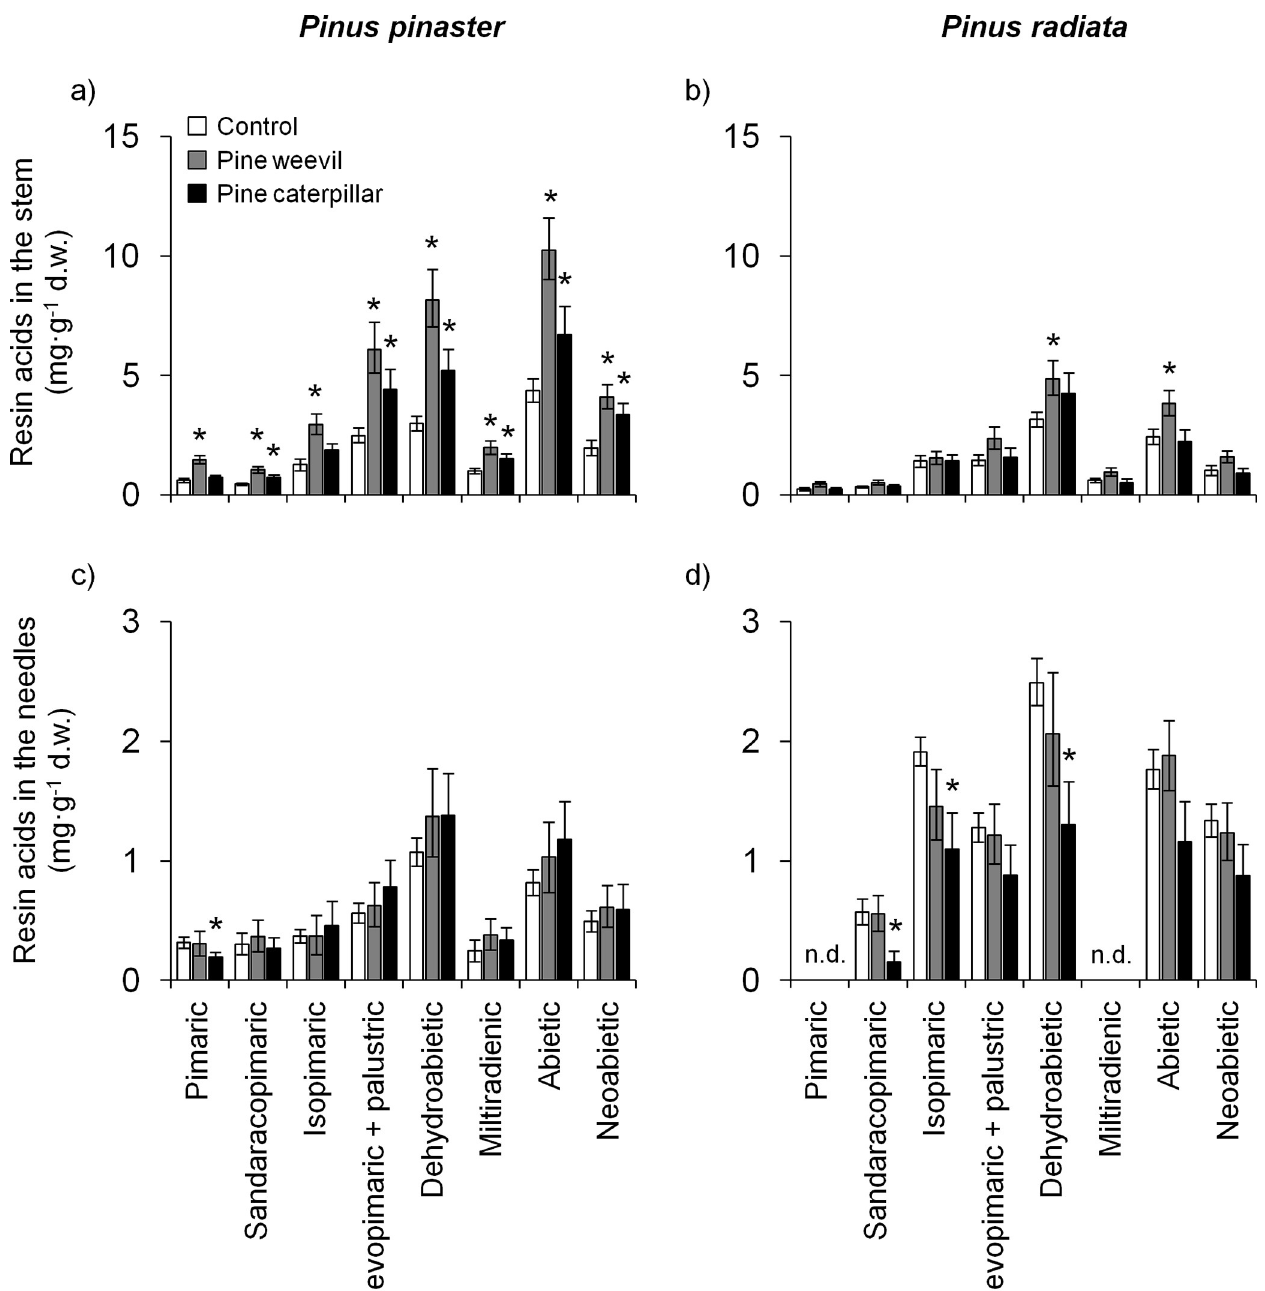
Fig 2. Effects of herbivory-induction by pine weevil (grey bars) and pine caterpillar (black bars) on the concentration of individual resin acids in the stem phloem and in the needles of two pine species. LS means ± s.e. (N = 9–10). The asterisk above bars indicates significant differences between herbivory treatment in regard to control plants for each compound within each species ( P < 0.05). n.d. = not